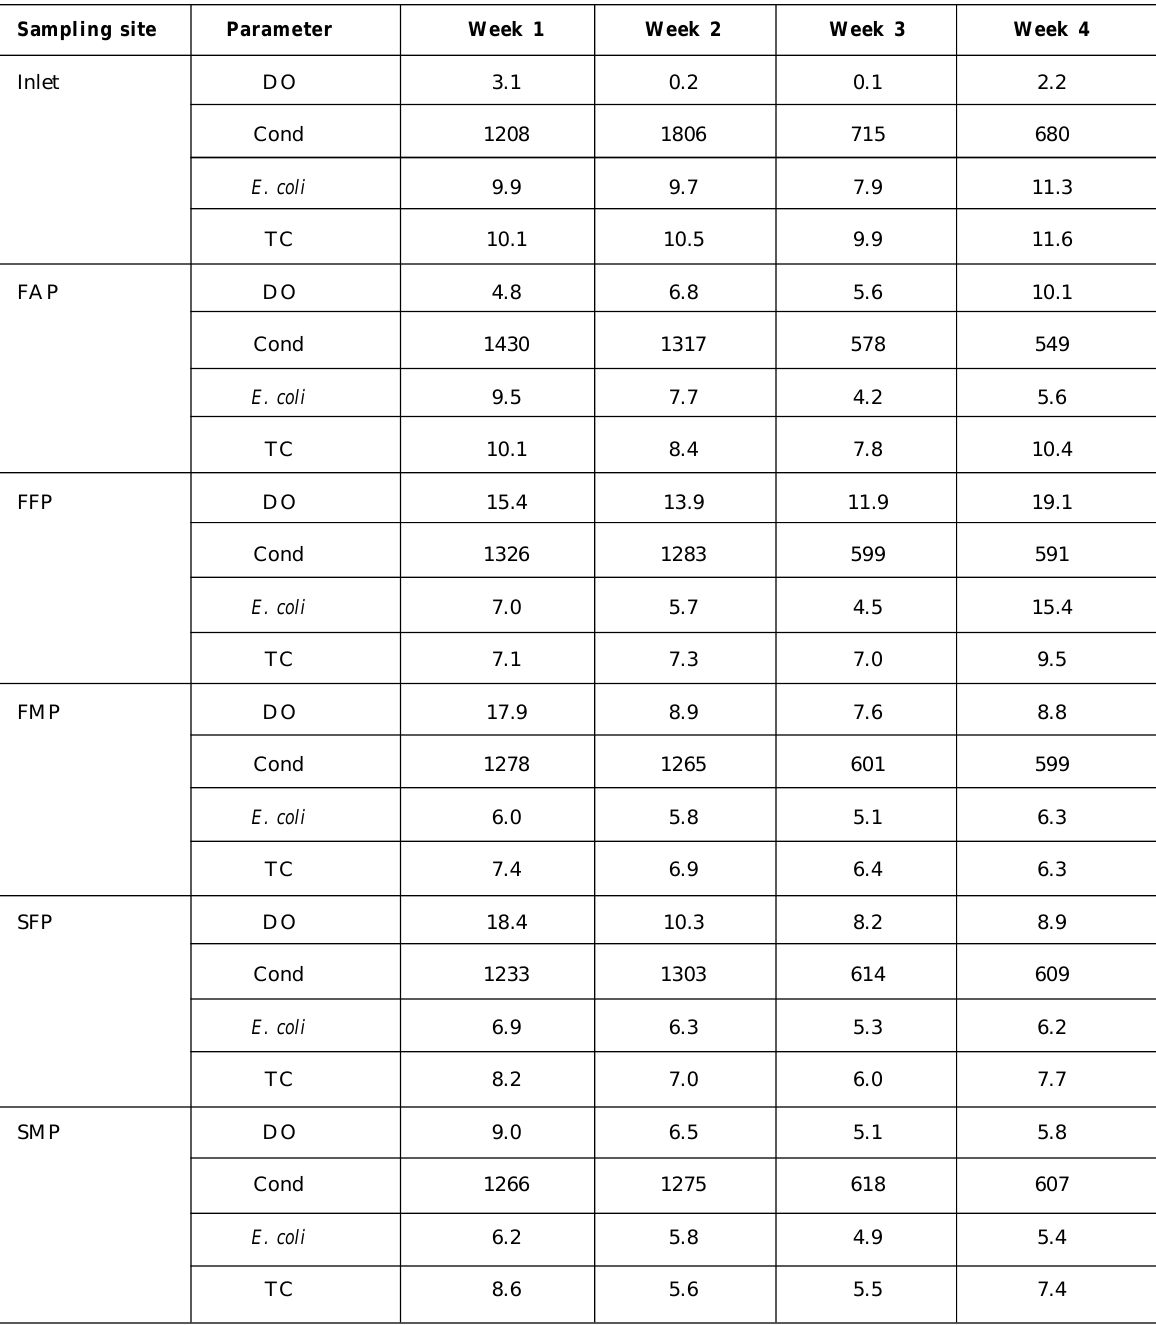
Table 2: Temporal variations of FIB with DO and conductivity Sampling